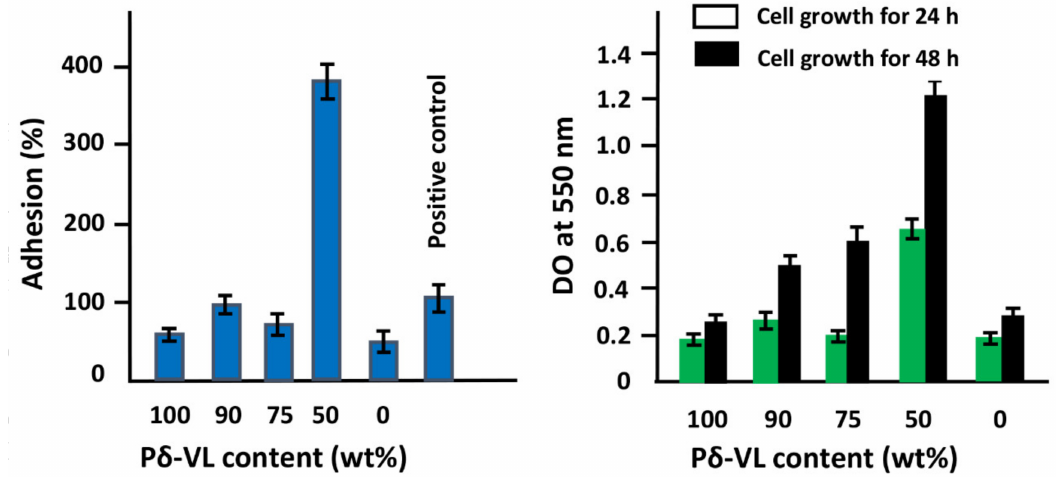
Figure 1. Cell adhesion and growth on the pure P δ -VL and PE- co -VAL/P δ -VL blend specimens with different P δ -VL contents. The error bars correspond to the standard deviation between the minimal and the maximal values obtained from four experiments. The positive control is the collagen membrane (collape) (adhesion 100%). The error bars correspond to the standard deviation between the minimum and maximum values obtained from the four experiments carried